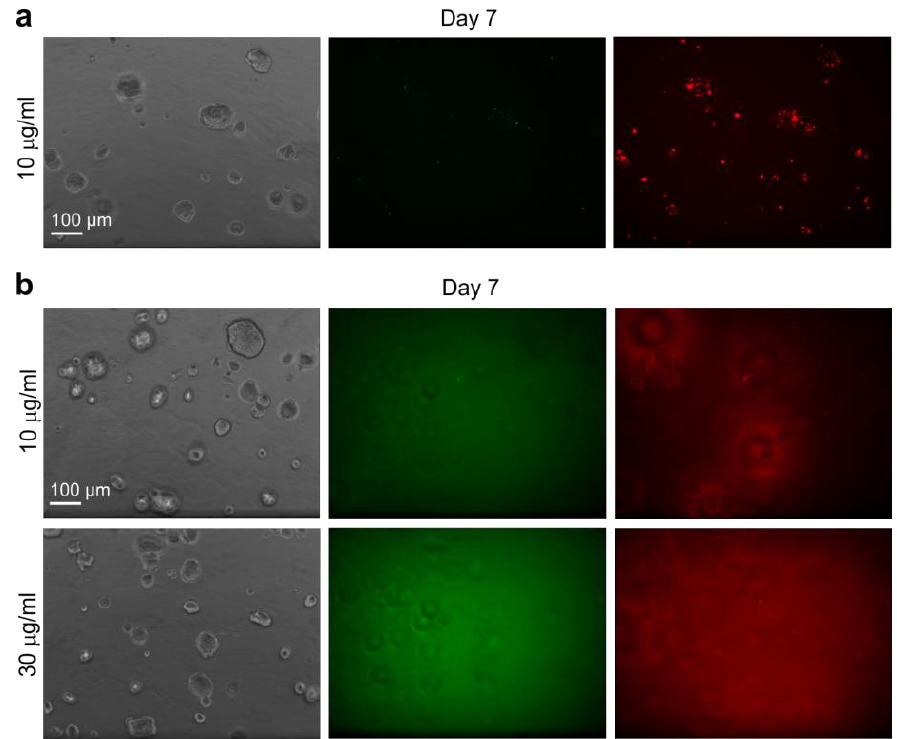
Figure 10. Labeling efficiency of hydrophilic calcein and hydrophibic DiI dyes as delivered by